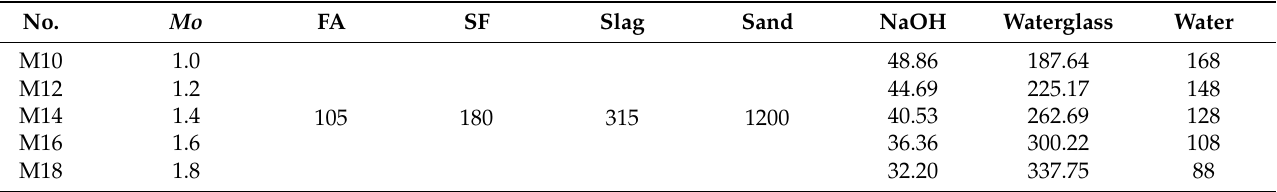
Table 4. Mixture proportions of group M (kg/m 3